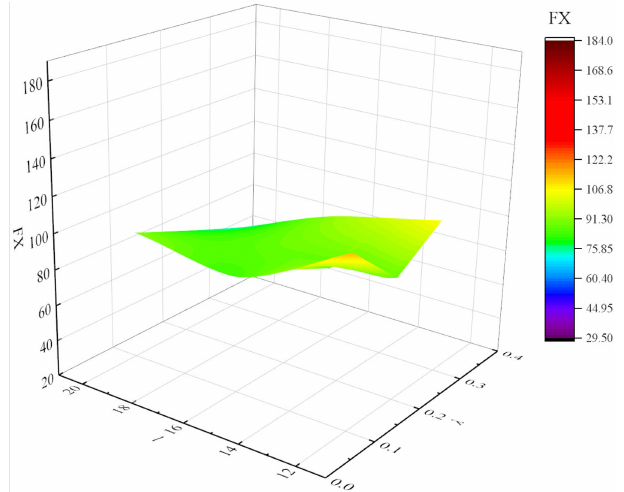
Figure 18. Effects of λ and l on traction.